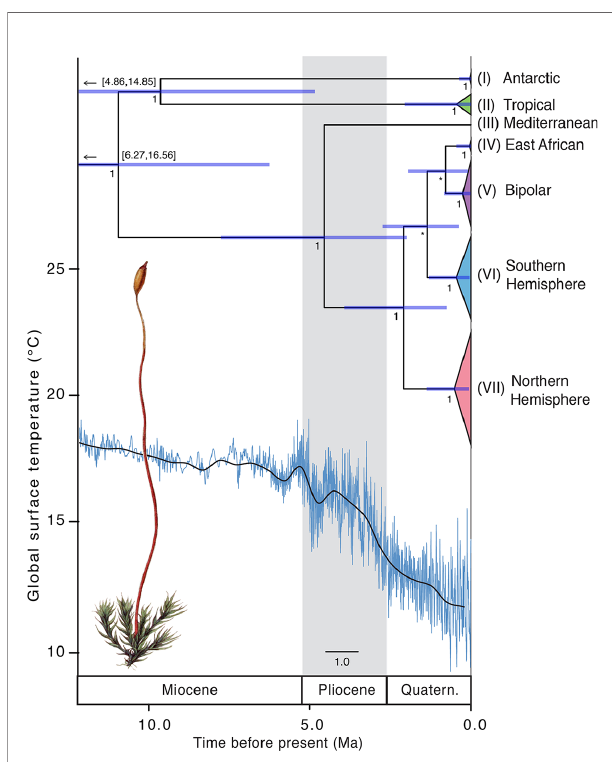
FIGURE 5 | Time-calibrated phylogeny of Ceratodon purpureus . The maximum clade credibility tree presents the median divergence time estimates for major lineages ( Figure 2A ) from a concatenated cpDNA data set ( atpB-rbcL + rps4 + trnL-F ) using a coalescent tree prior. Node bars represent 95% height posterior distribution of age estimates. Posterior support (PP) values are shown below nodes, with PP < 0.5 provided as *. Global surface temperature estimates (blue and solid line representing temperature variations and a 500kyr smoothed resolution, respectively), reproduced from Hansen et al. 2013, are provided below. Due to the old age (62.78 Mya; 95HDP 26.94 – 91.13 Mya; ) the split of the outgroup Cheilothela chloropus and Ceratodon purpureus is not shown in this fi gure. Note that the lower part of the 95HPD range of the two oldest nodes is not shown, but given in numbers above the node bars. Scale bar indicates the number of substitutions per site. Illustration by Christiaan Sepp (Kops et al., 1868; Wikimedia